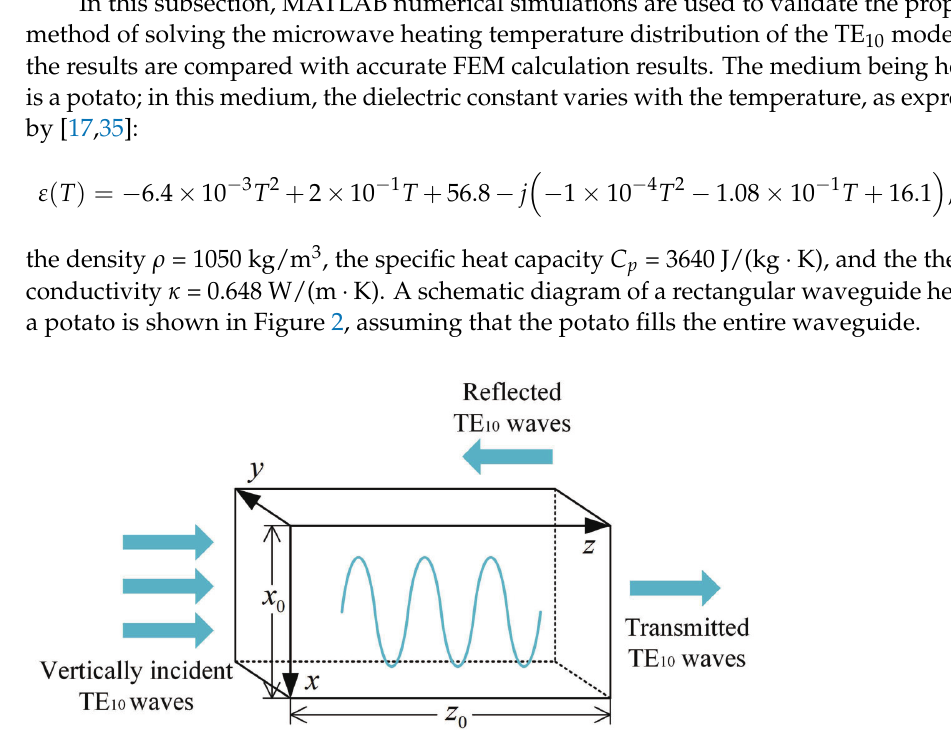
Figure 2. Schematic diagram of a heated potato in a rectangular